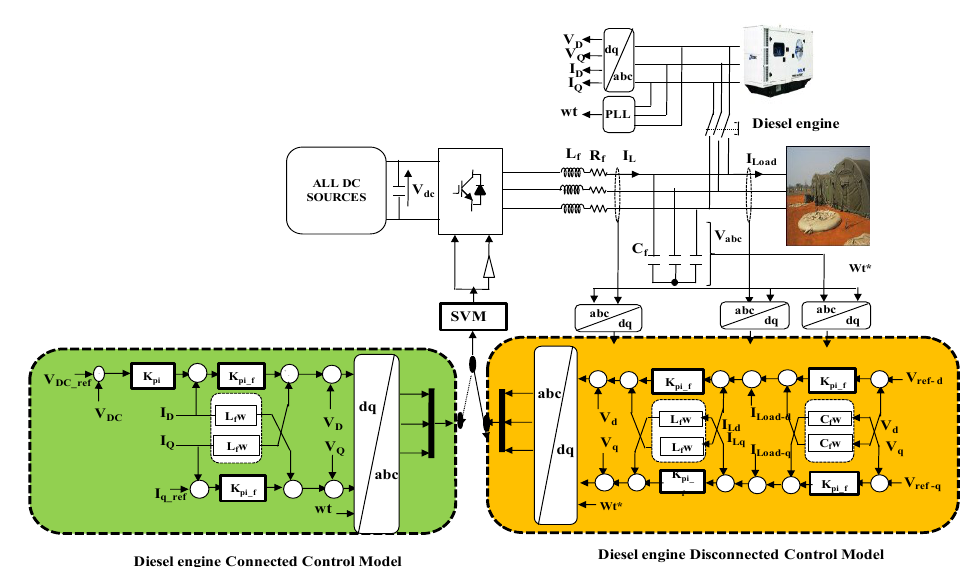
Figure 13. Inverter control approaches for both grid-connected and disconnected modes. Using (19) and (20), the final expression is given by: